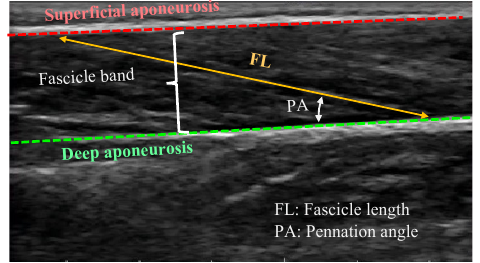
Figure 1. Ultrasound image of gastrocnemius